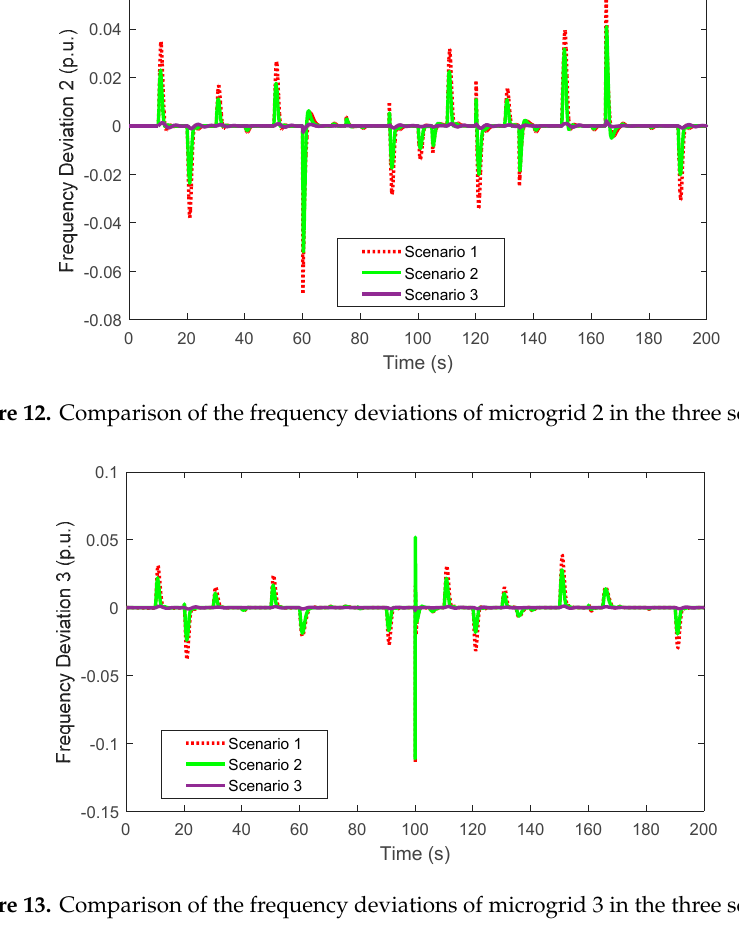
Figure 13. Comparison of the frequency deviations of microgrid 3 in the three scenarios.